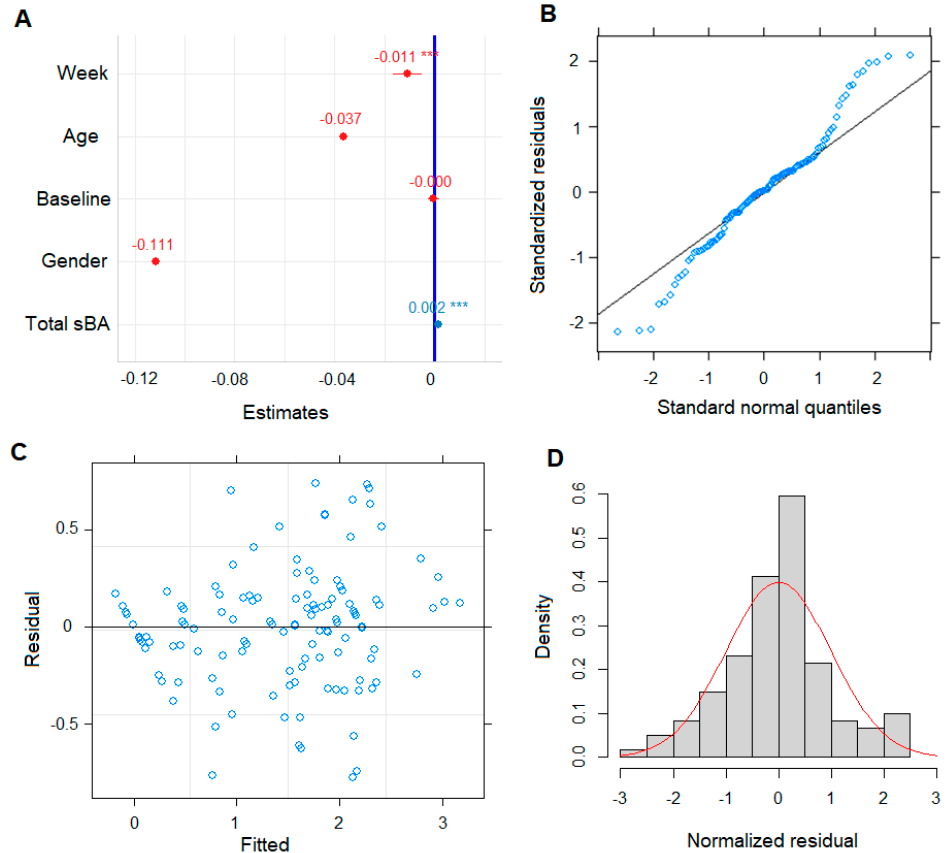
Figure 3. Evaluation of total sBA as a biomarker (predictor) in building the LMM model. Coefficients of fixed factors/effects, i.e., total sBA concentration during the study period, weeks of patients on MRX in study, initial age and gender of patients, and sBA pre-dose baseline from LMM model, whiskers span the 95% CI, ***p-value<0.001, color of a dot indicate the factor/covariate has negative (red) or positive (blue) effects on ItchRO score ( A ); QQ-plot of residuals for normality check ( B ); residual plot against the fitted values for homoscedasticity ( C ); and histogram of normalized residuals ( D ).